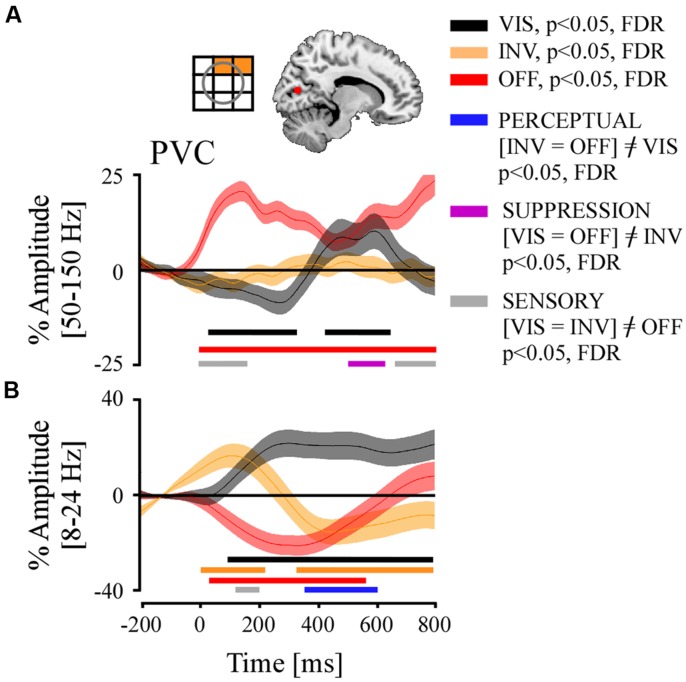
Grand average of time-resolved high and low frequency responses and their comparison statistics for stimulus visibility (VIS), invisibility (INV), and stimulus offset (OFF) in the PVC. Above (A), left panel, a retinotopic receptive field map of recording sites, and right panel, localization of electrodes projected on MNI reference brain. (A) Broadband gamma responses, significant time-samples of neural emergence test and of condition contrasts. (B) Low-frequency responses, same conventions as in (A).